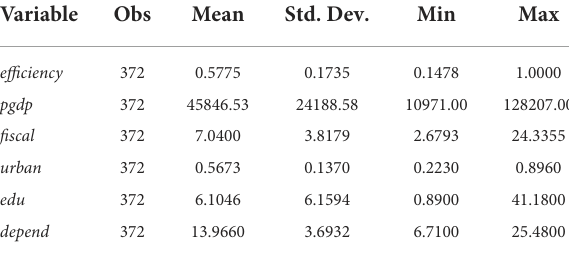
TABLE 3 Descriptive statistics of regression